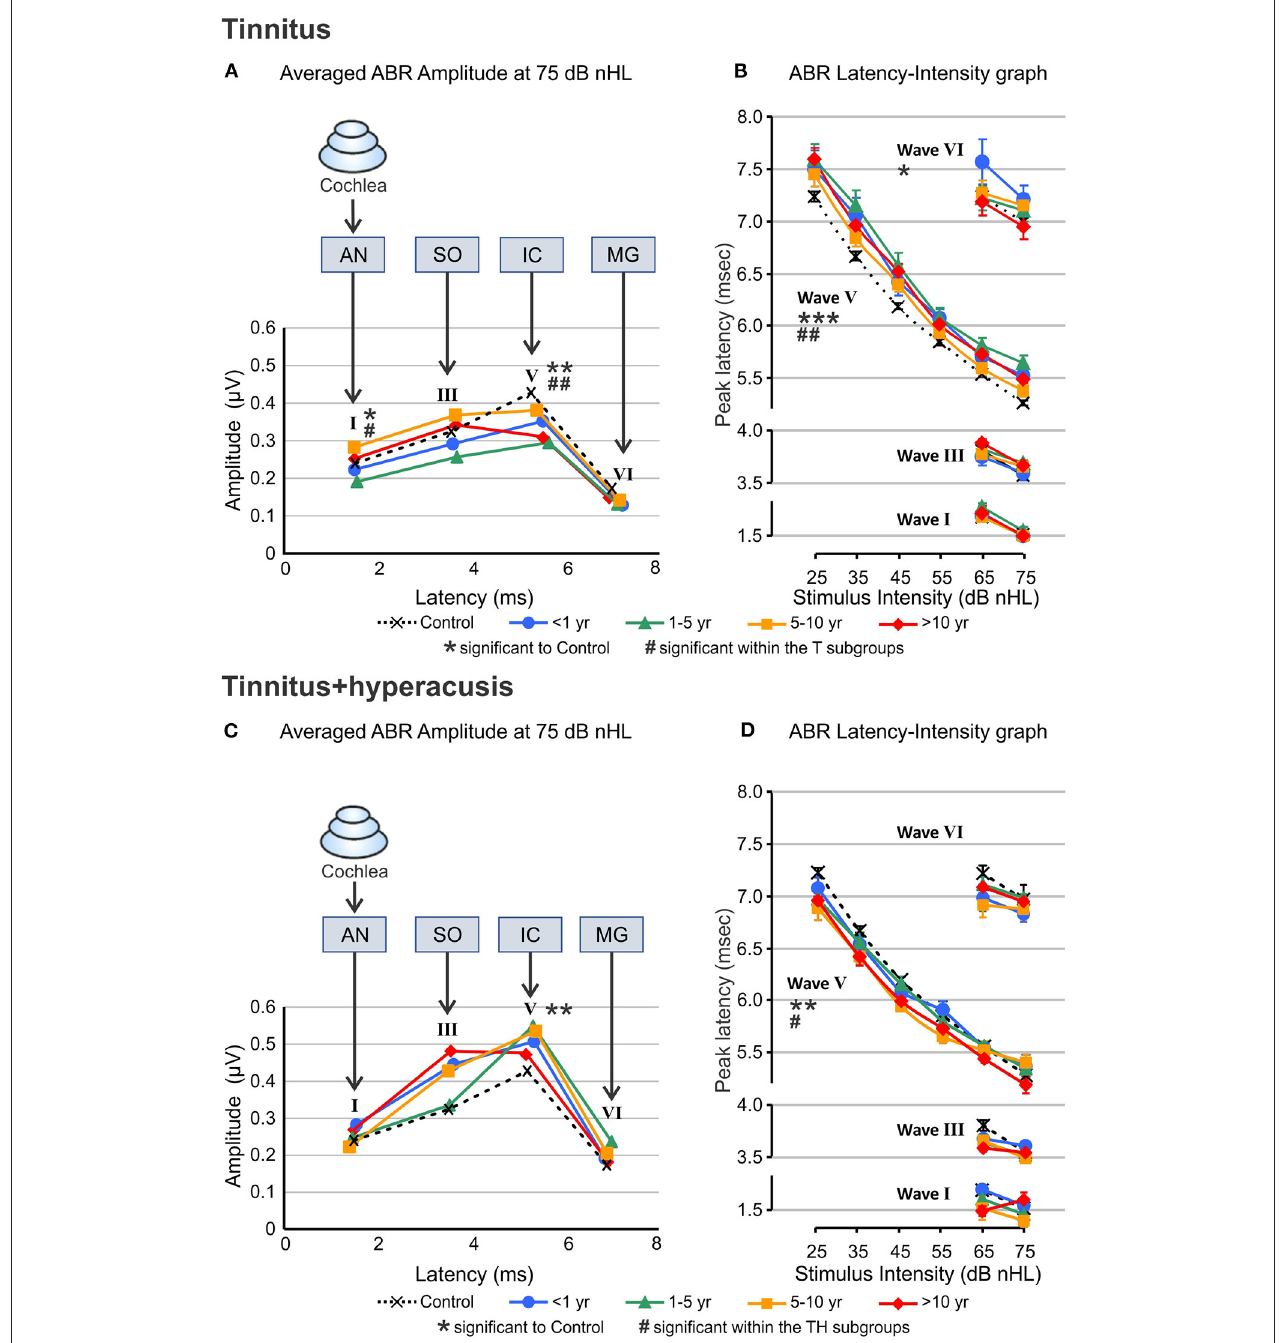
FIGURE 6 | Auditory brainstem response wave amplitudes and latencies calculated from ABR responses to 25–75 dB nHL click stimuli. (A , C) Average amplitude of ABR wave I, III, V, and VI for 75 dB nHL stimuli for participants with tinnitus (A) and both, tinnitus + hyperacusis (C) categorized according to the duration of their tinnitus (colored curves) and compared to healthy controls (black dashed line and symbols). The amplitudes for either wave were displaced horizontally according to the average latency of the respective wave (latency, ms). AN, SO, IC, and MG illustrate the presumed brain structure origin for the wave I, II, V, and VI, respectively. (B, D) Peak latency as a function of stimulus intensity for the ABR Wave I, II, V, and VI across the stimulation range from 25 to 75 dB nHL. Peak values were clearly measurable only from 65 to 75 dB nHL. Data represent responses from both ears averaged of n = 33 tinnitus, n = 20 tinnitus + hyperacusis, and n = 43 control participants. Wave V exhibit reduced amplitude and prolonged latency regardless of the duration of the tinnitus in T-group, while in TH-group the increase in the amplitude become more over time. Level of significance is illustrated in the figures (significance to control: * P ≤ 0.05; ** P < 0.01; *** P < 0.001; significance within the subgroups: # P ≤ 0.05; ## P < 0.01). For detailed statistics (2-way ANOVA) see Supplementary Table 4 . ABR, auditory brainstem response; dB, decibel; nHL, normalized hearing level; AN, auditory nerve; SO, superior olivary complex; IC, inferior colliculus; MG, medial geniculate body of the